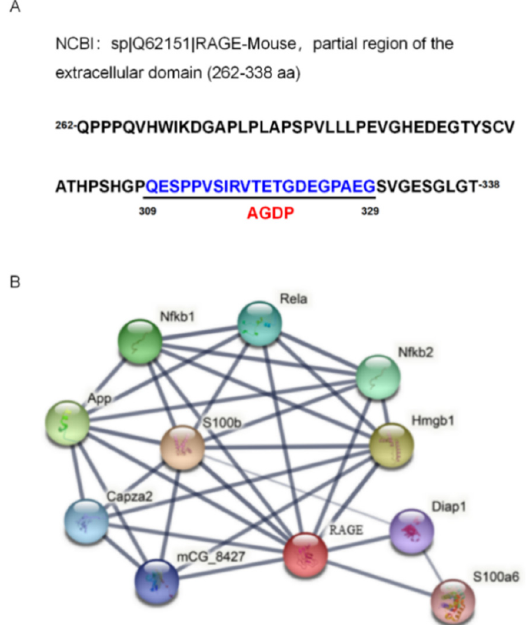
Figure 5. Location of AGDP on precursor protein RAGE and mapping of RAGE protein interaction. ( A ) Localization of AGDP on RAGE protein; ( B ) Interaction network analysis of RAGE and its associated proteins. The image was made according to STRING (Version 11.5, http://string ‐ dg.org/, accessed on 15 December 2021).